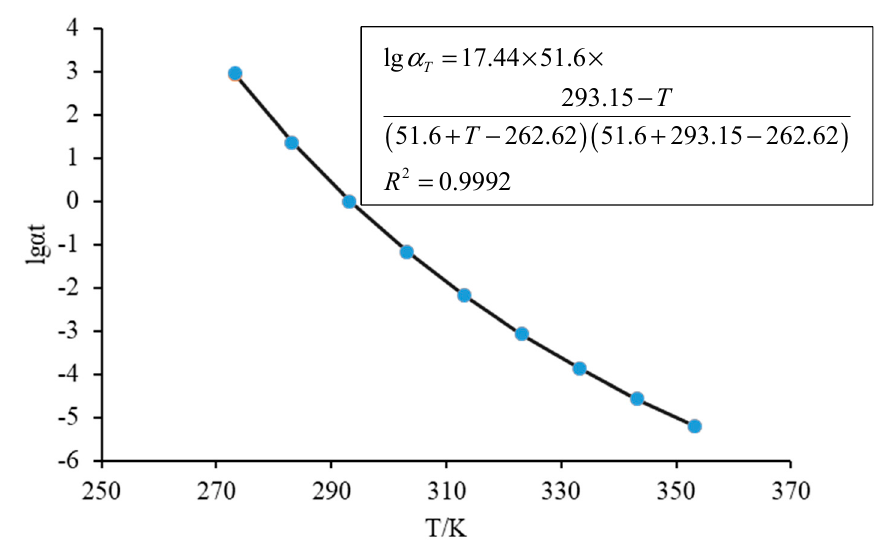
Figure 4. Fitting results of T g of SBS modified